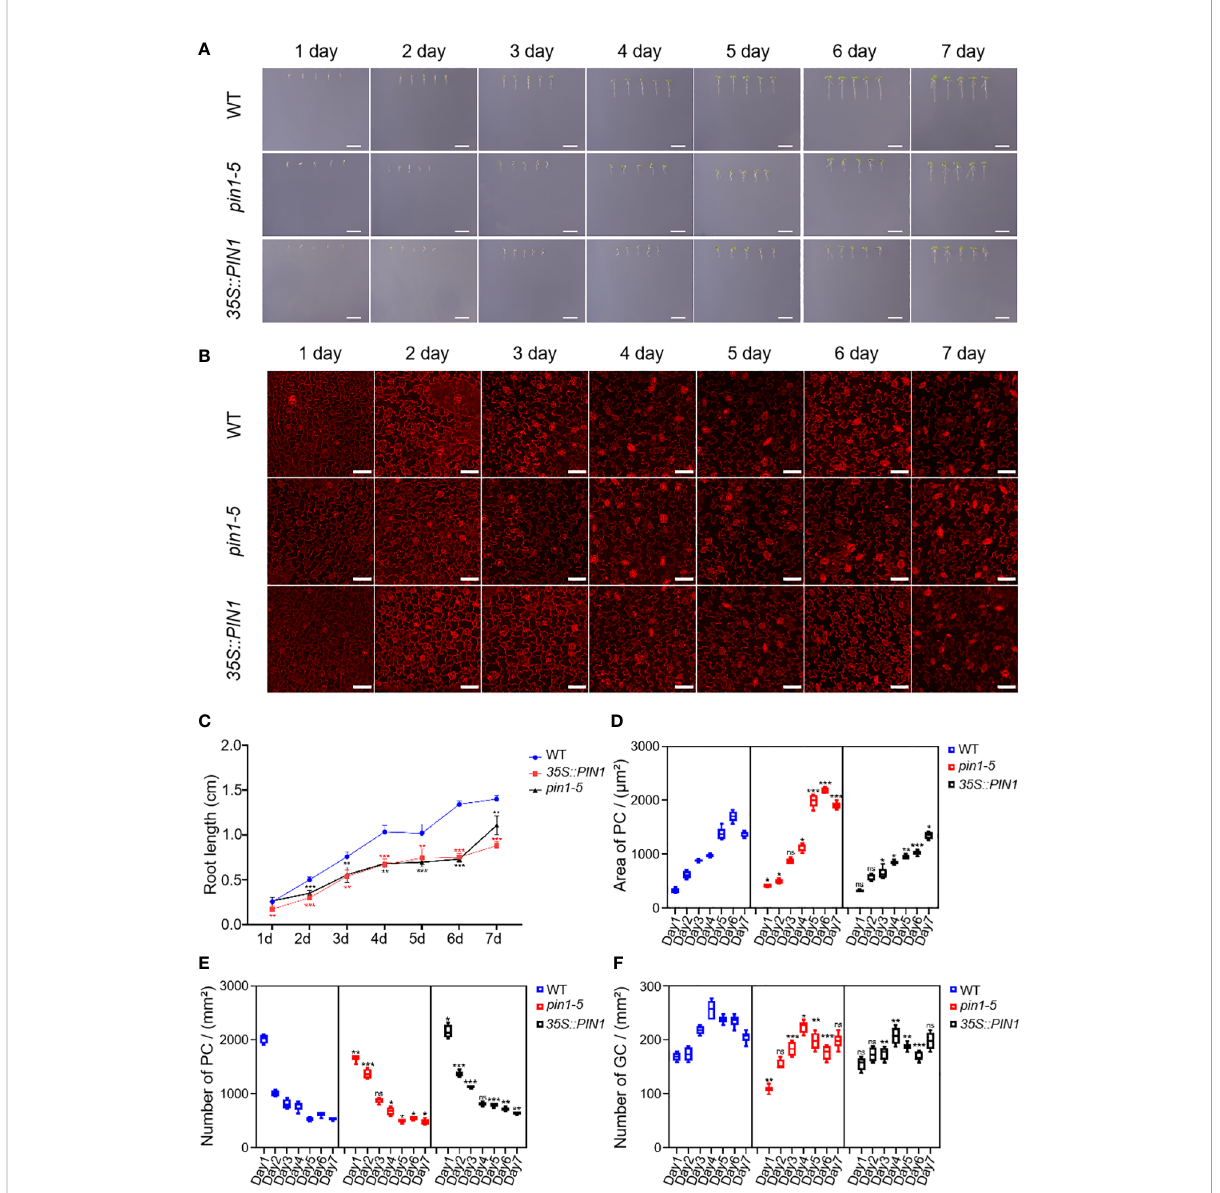
FIGURE 6 AnalysisofPCandGCdevelopmentin pin1-5 , 35S::PIN1 andWTunderdroughtconditions.Analysisofthegrowthof pin1-5 , 35S::PIN1 andWTundercontrol conditions. (A) Theseedingof pin1-5 , 35S::PIN1 andWTweregrownin1/2MSplatesplus150mMmannitolfor7days.Theseedlingsborn1-7werephotographed continuouslybyacameratorecordtheirdevelopmentalandgrowthphenotypes,anduntreatedseedlingswereusedascontrols.Scalebar:1cm. (B) The developmentofPCandGCwasmeasuredunderthefollowingconditions: pin1-5 , 35S::PIN1 andWTseedlingsweregrownin1/2MSplatesplus150mMmannitol for1 – 7days,thenharvestedandstainedwithPIfor30mintostainthemembrane.AfterPIstaining,PCandGC ′ sweredetectedunderaconfocallasermicroscope. Scalebar:50 m m. (C) Statisticalanalysisoftherootlengthofseedlingsof pin1-5 , 35S::PIN1 andWT(n=5). (D) StatisticalanalysisofthesizeofPCsinthelower epidermisofcotyledonsofseedlingsof pin1-5 , 35S::PIN1 andWT(n=5). (E) StatisticalanalysisoftheintensityofPCsinthelowerepidermisofcotyledonsof seedlingsof pin1-5 , 35S::PIN1 andWT(n=5). (F) StatisticalanalysisoftheintensityofGCsinthelowerepidermisofcotyledonsofseedlingsof pin1-5 , 35S::PIN1 and WT(n=5).Thedatawereanalyzedbyone-wayANOVAfollowingBrown –